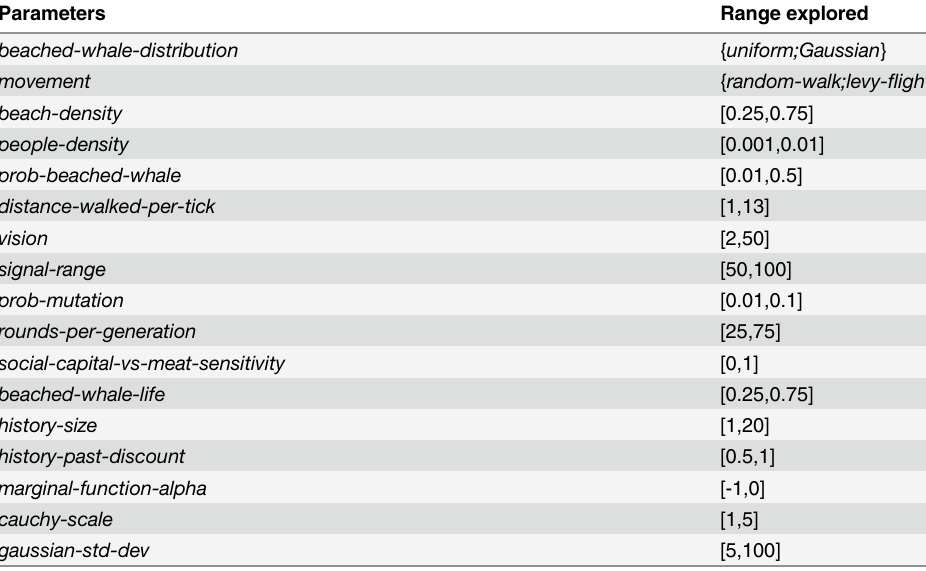
Table 5. Parameters of the